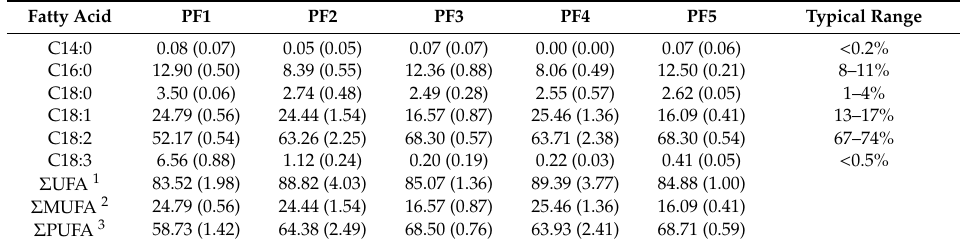
Table 1. Fatty acid profiles of the passion fruit oil products. The numbers are mean values of multiple measurements and the standard deviations are given in parentheses. The numbers are expressed as percentages of the total fatty acid content. The typical ranges are given for comparison; these numbers were derived from the literature [5,37,38].